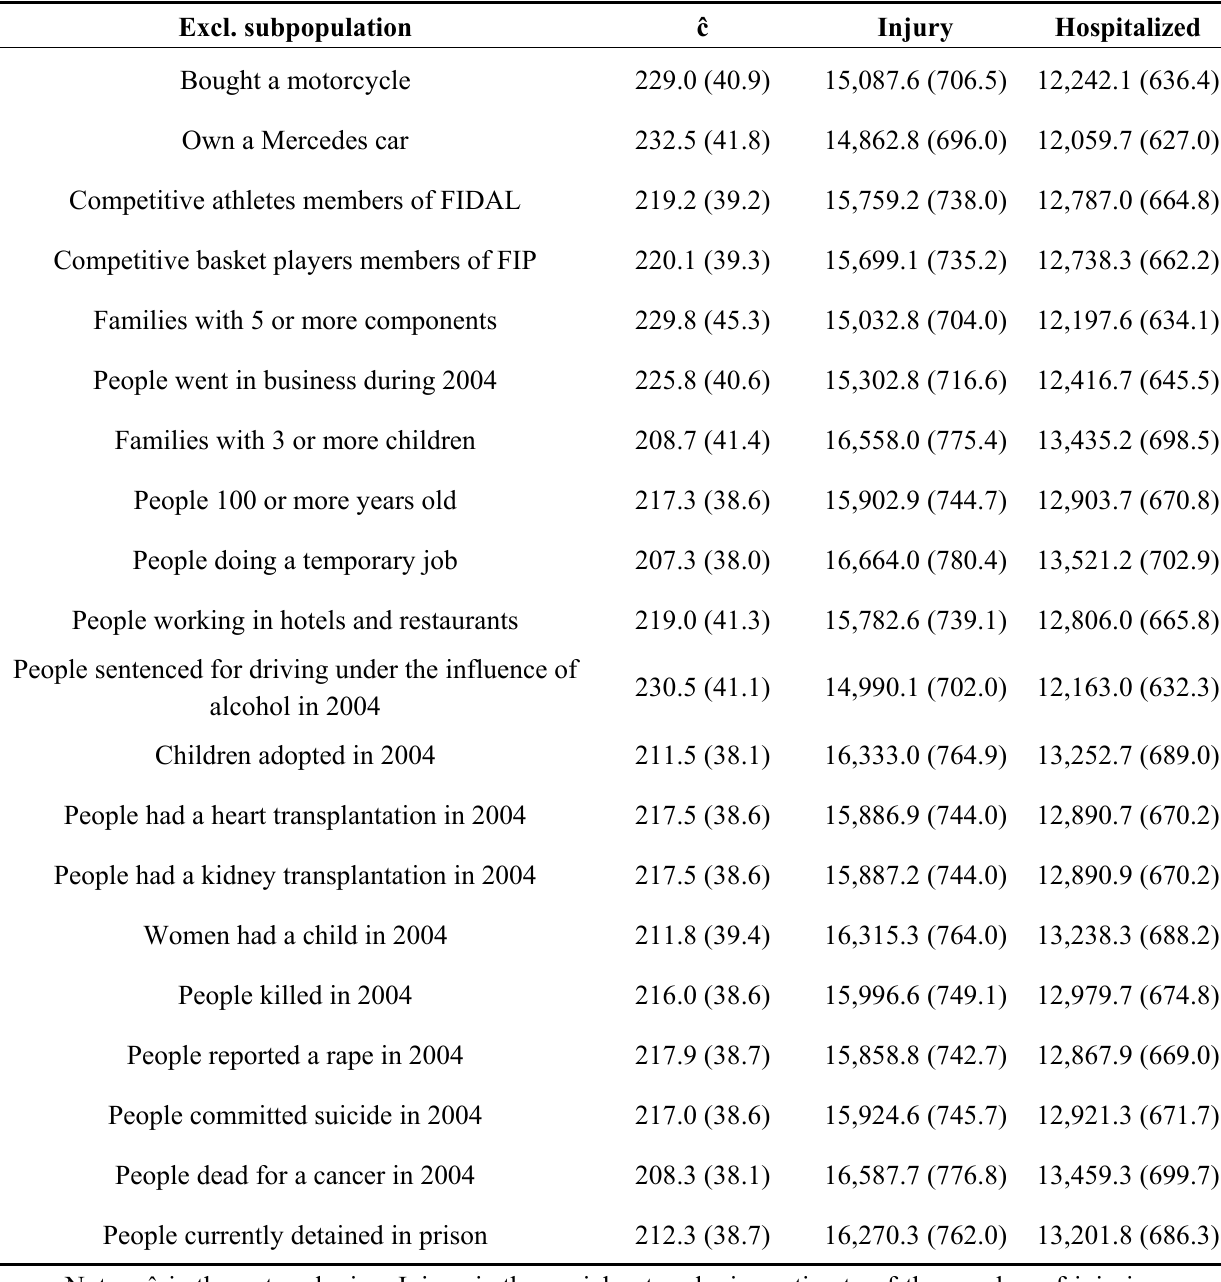
Table 3. Results of the sensitivity analysis for each subpopulation excluded from the